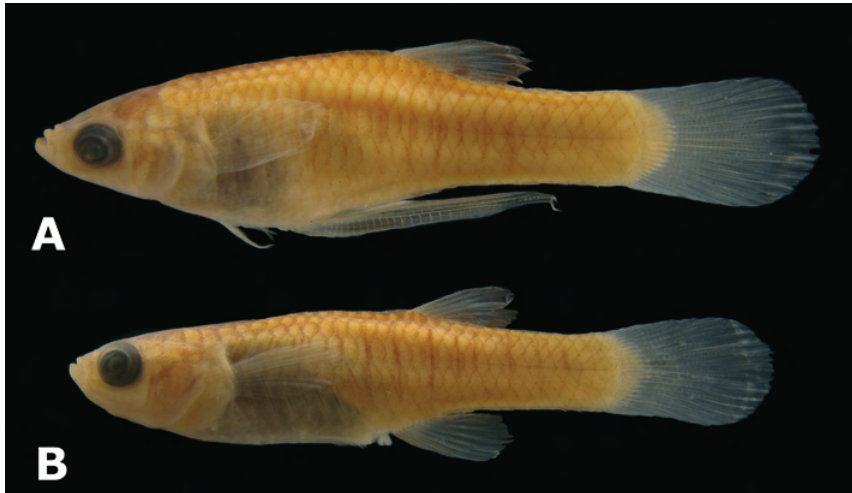
Fig. 8. Phalloceros heptaktinos . (A) Holotype, male, 24.0 mm SL, MCP 30406, stream affluent to arroio dos Ratos,